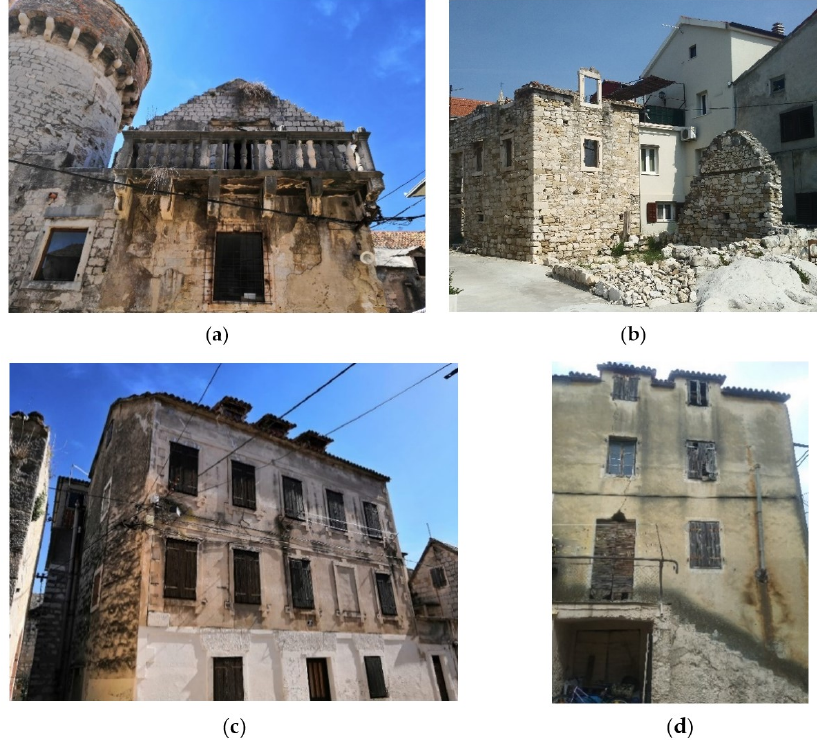
Figure 5. Current state of buildings in the historic centre: ( a ) damage to Cambi tower; ( b ) completely demolished building; ( c , d ) significant cracks in the load-bearing walls of residential